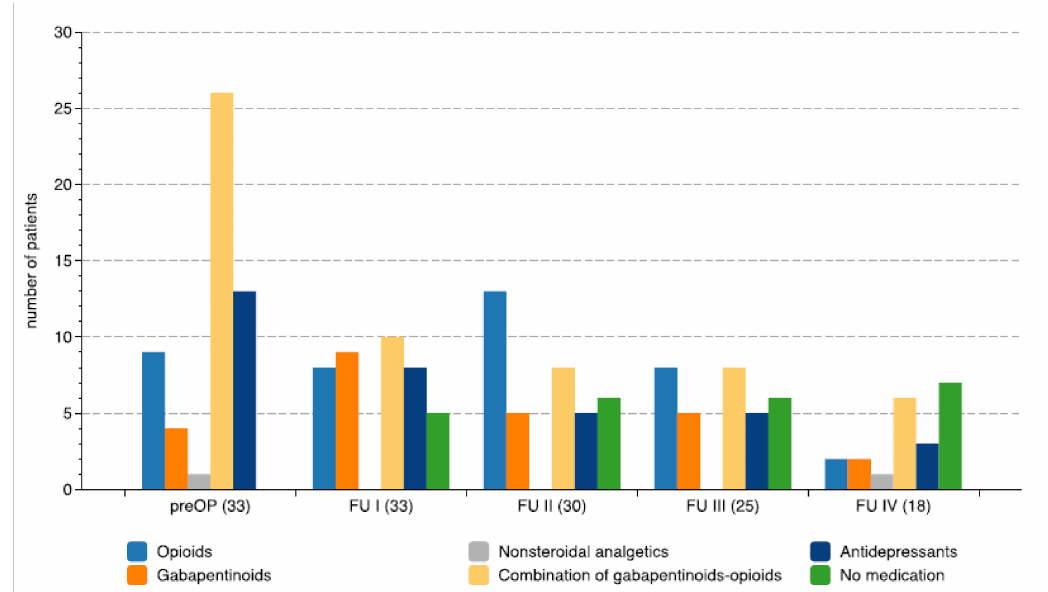
Figure 6. Changes in medication during chronic thalamic deep brain stimulation. The diagram shows the number of patients taking different medications at the defined follow-up periods. The number of patients available at these follow-up periods are in